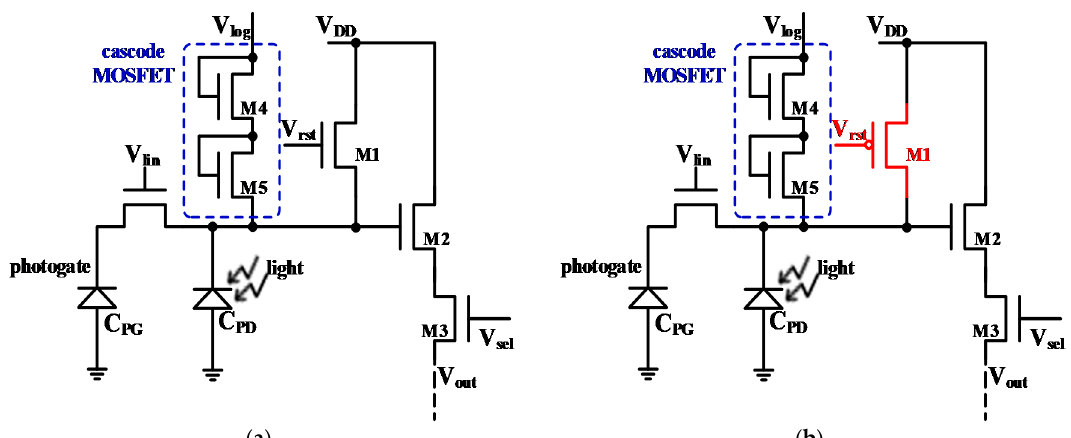
Figure 1. Schematic diagrams; ( a ) conventional linear-logarithmic pixel and ( b ) proposed linear-logarithmic